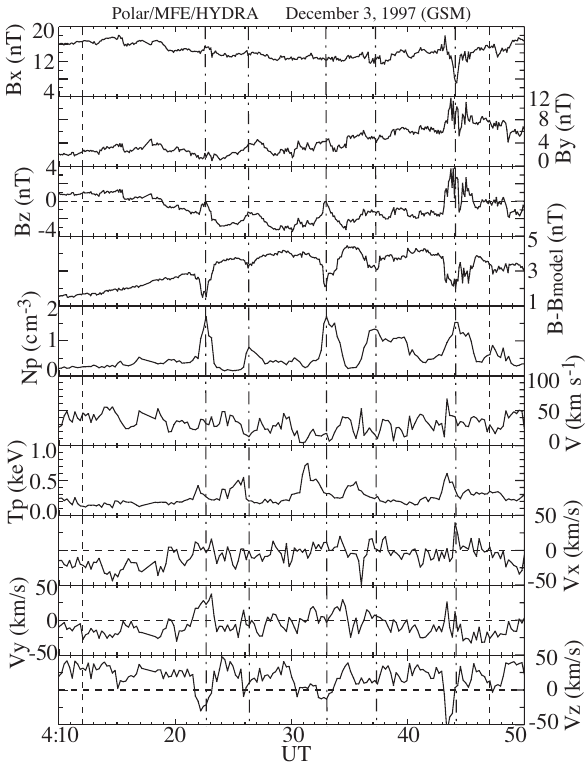
Fig. 4. Expanded view of Polar magnetic field and plasma moments from the interval marked I in Fig. 1. Top to bottom: Magnetic field components; magnetic field magnitude (IGRF model subtracted); proton density, bulk speed, temperature, and velocity components. Vertical dash-dot lines indicate flow bursts which are consistent with FTE signatures.